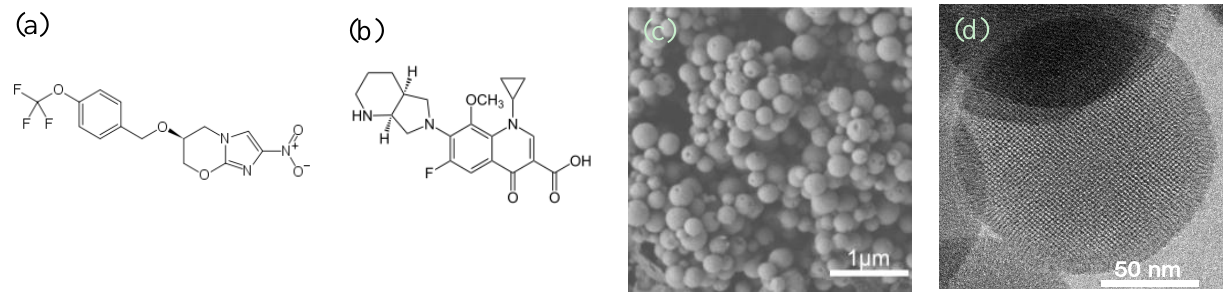
Figure 1. Molecular structure of ( a ) PA-824 and ( b ) moxifloxacin; ( c ) scanning and Transmission Electron Microscopy images of typical particles of calcined ( d ) transmission electron microscopy images of typical particles of calcined AMS-6.